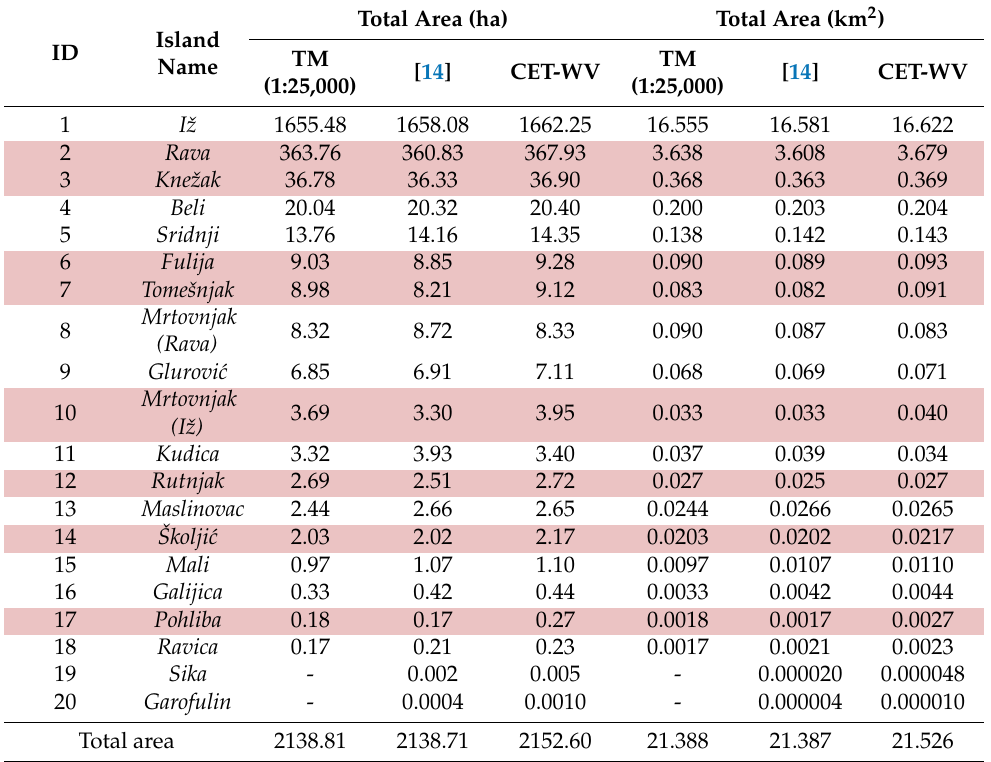
Table 5. Extracted area of the Iž-Rava island group (Red-labeled islands characterize a large presence of shadow-induced errors, which significantly raised the total island area extracted by the tool developed in